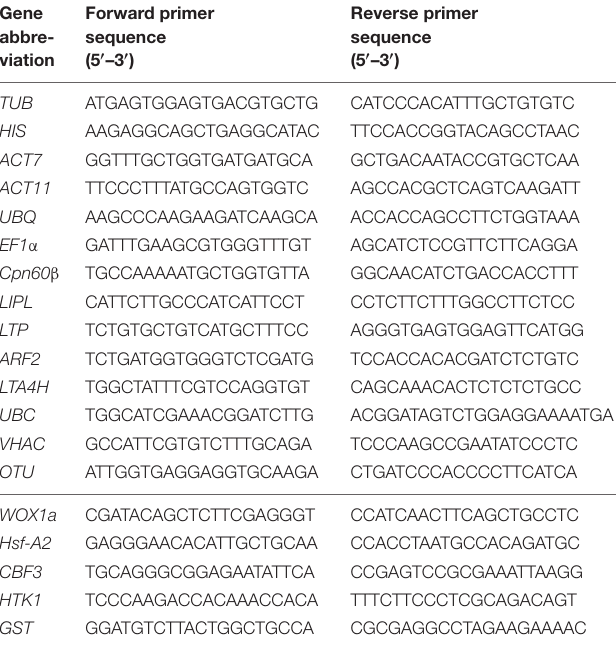
TABLE 2 | The primer sequences used in this study.